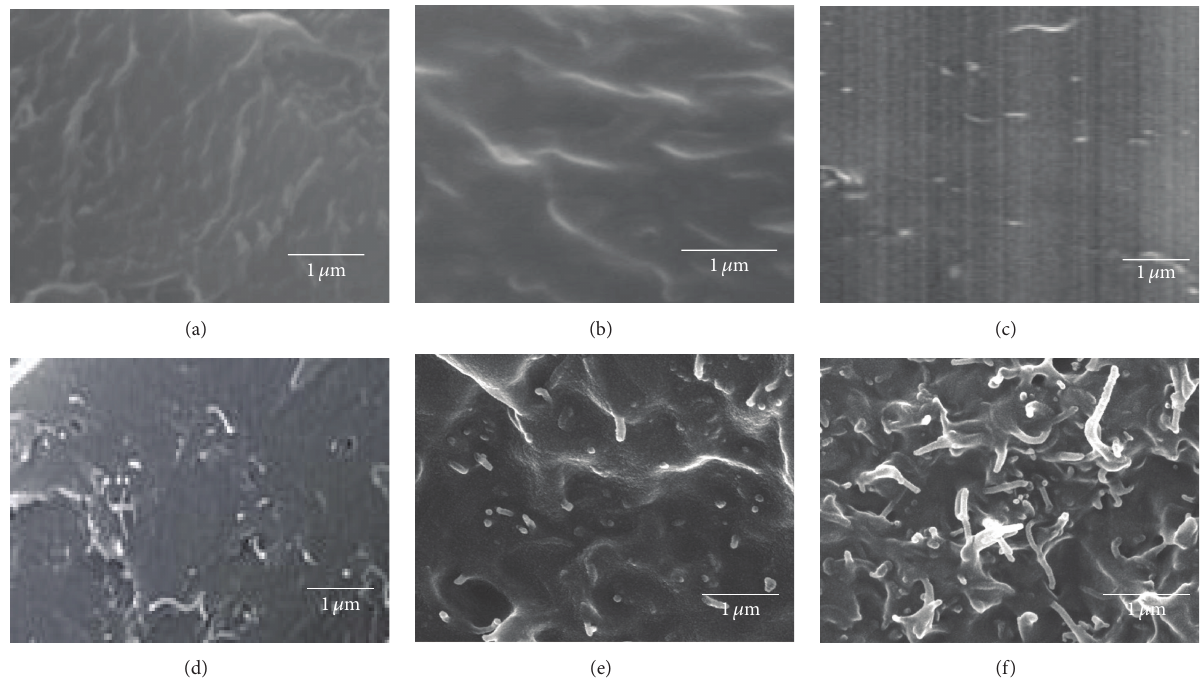
Figure 2: High resolution cross-sectional scanning electron micrographs of unfilled PB (a) and CNTs/PB nanocomposites filled with 0.5 (b), 1 (c), 2 (d), 4 (e), and 8 (f) wt.% CNTs.